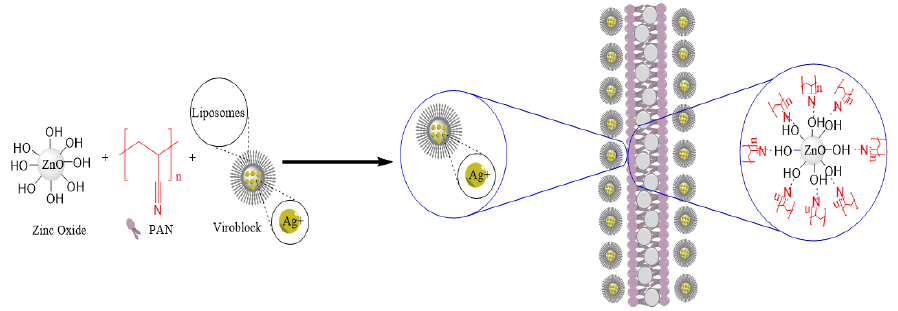
Figure 2. Chemical reaction for the fabrication of antiviral nanofibers.